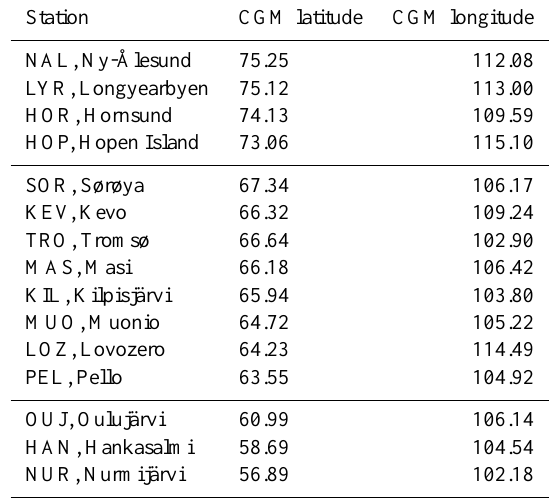
Table 1. Corrected geomagnetic coordinates of the IMAGE magne- tometer stations used in this study. The stations are listed from north to south, and the station groups (Region 1, Region 2 and Region 3) have been separated by horizontal